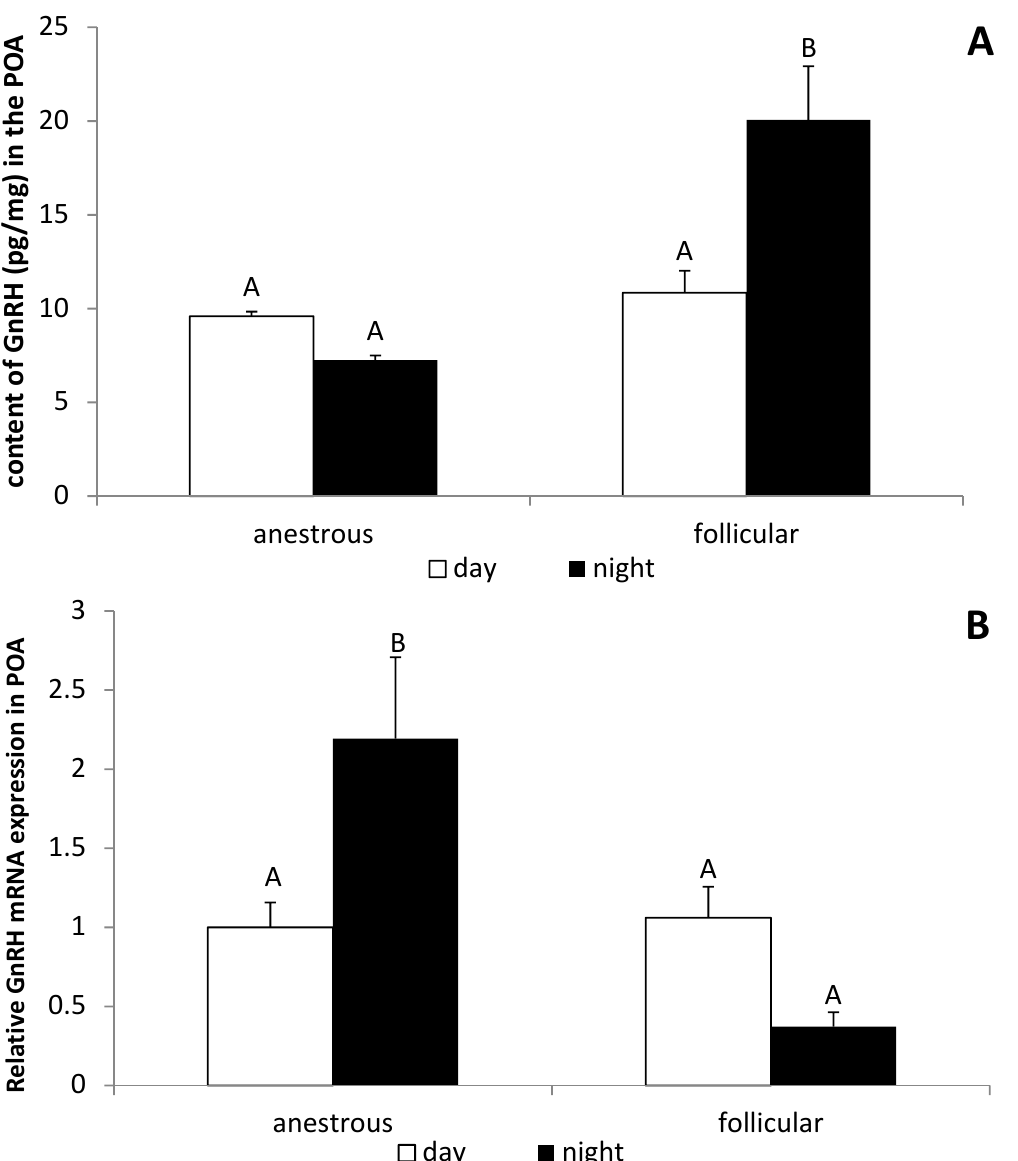
Figure 3. The day/night changes in the GnRH peptide ( A ) and mRNA ( B ) expression in the preoptic area (POA) of the anestrous and follicular phase ewes. Gene expression data were normalised to the average relative level of GnRH gene expression measured in the anestrous animals from the day experiment, which was set to 1.0. All data are presented as the mean ( ± S.E.M.). Different capital letters indicate significant ( p < 0.05) differences according to a two-way ANOVA followed by NIR Fisher’s post-hoc test.